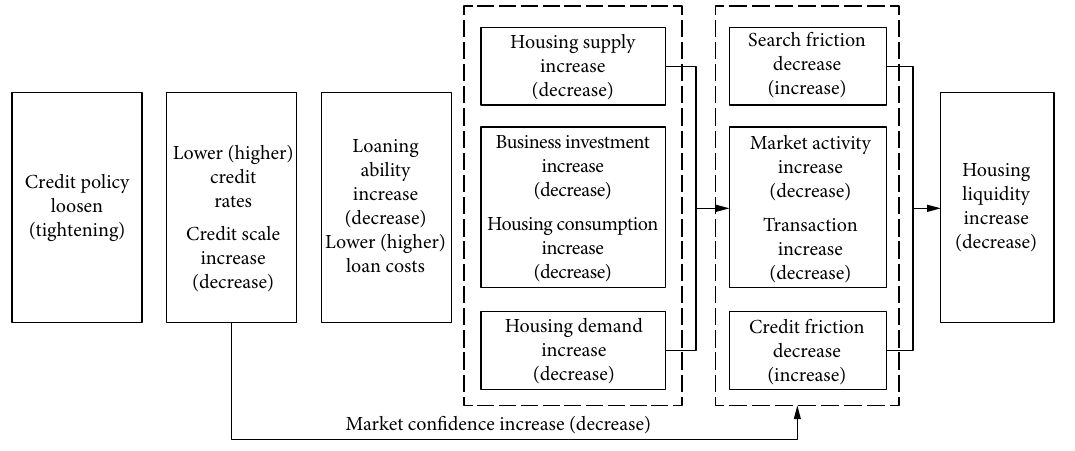
Fig. 1 Influencing mechanisms of credit policy on housing market